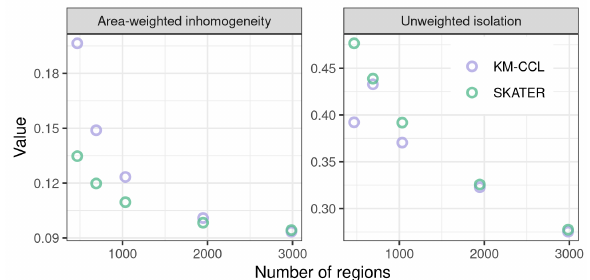
Figure 4. Comparison of area-weighted inhomogeneity (the lower the better) and unweighted isolation (the larger the better) beteen various number of regions created using the KM-CCL and the SKATER